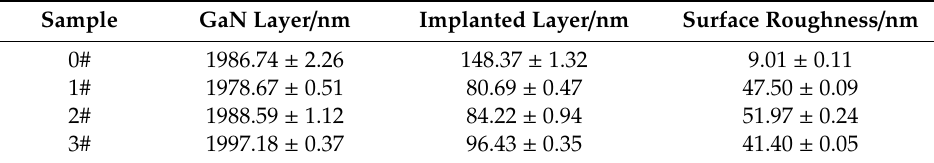
Table 1. Thicknesses information of Be implantation into GaN from SE.